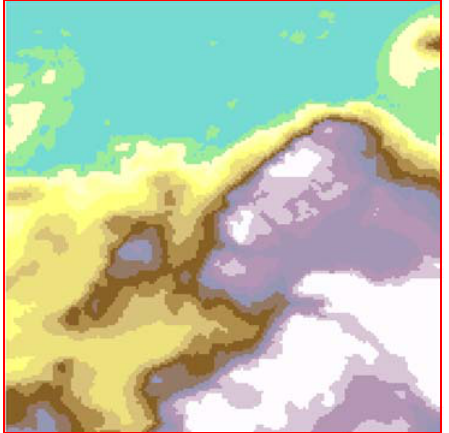
Figure 2a ASTER GDEM v2 heights, Plockton area Figure 2b OSGB Profile heights, Plockton area.